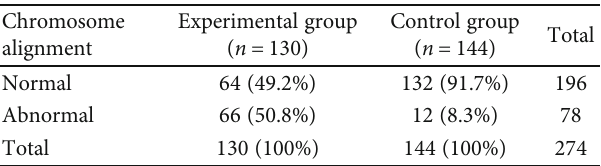
Table 4: Comparison of chromosome alignment between the experimental group and the control